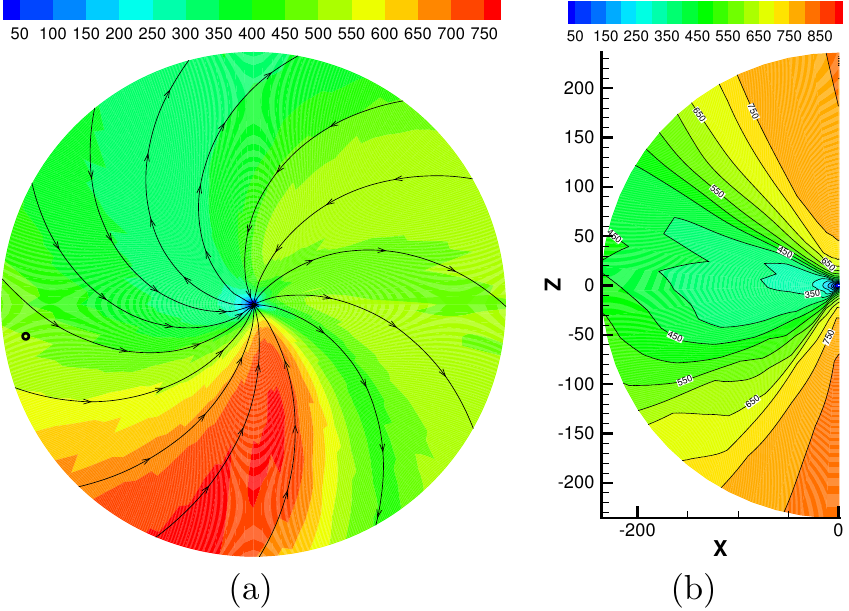
Figure 3. ( a ) Steady state solution in the solar equatorial plane. The black streamlines denote the magnetic field lines. The black circle represents Earth. ( b ) Steady state solution in the Sun–Earth meridional plane. The color contours represent the radial speed (km s − 1